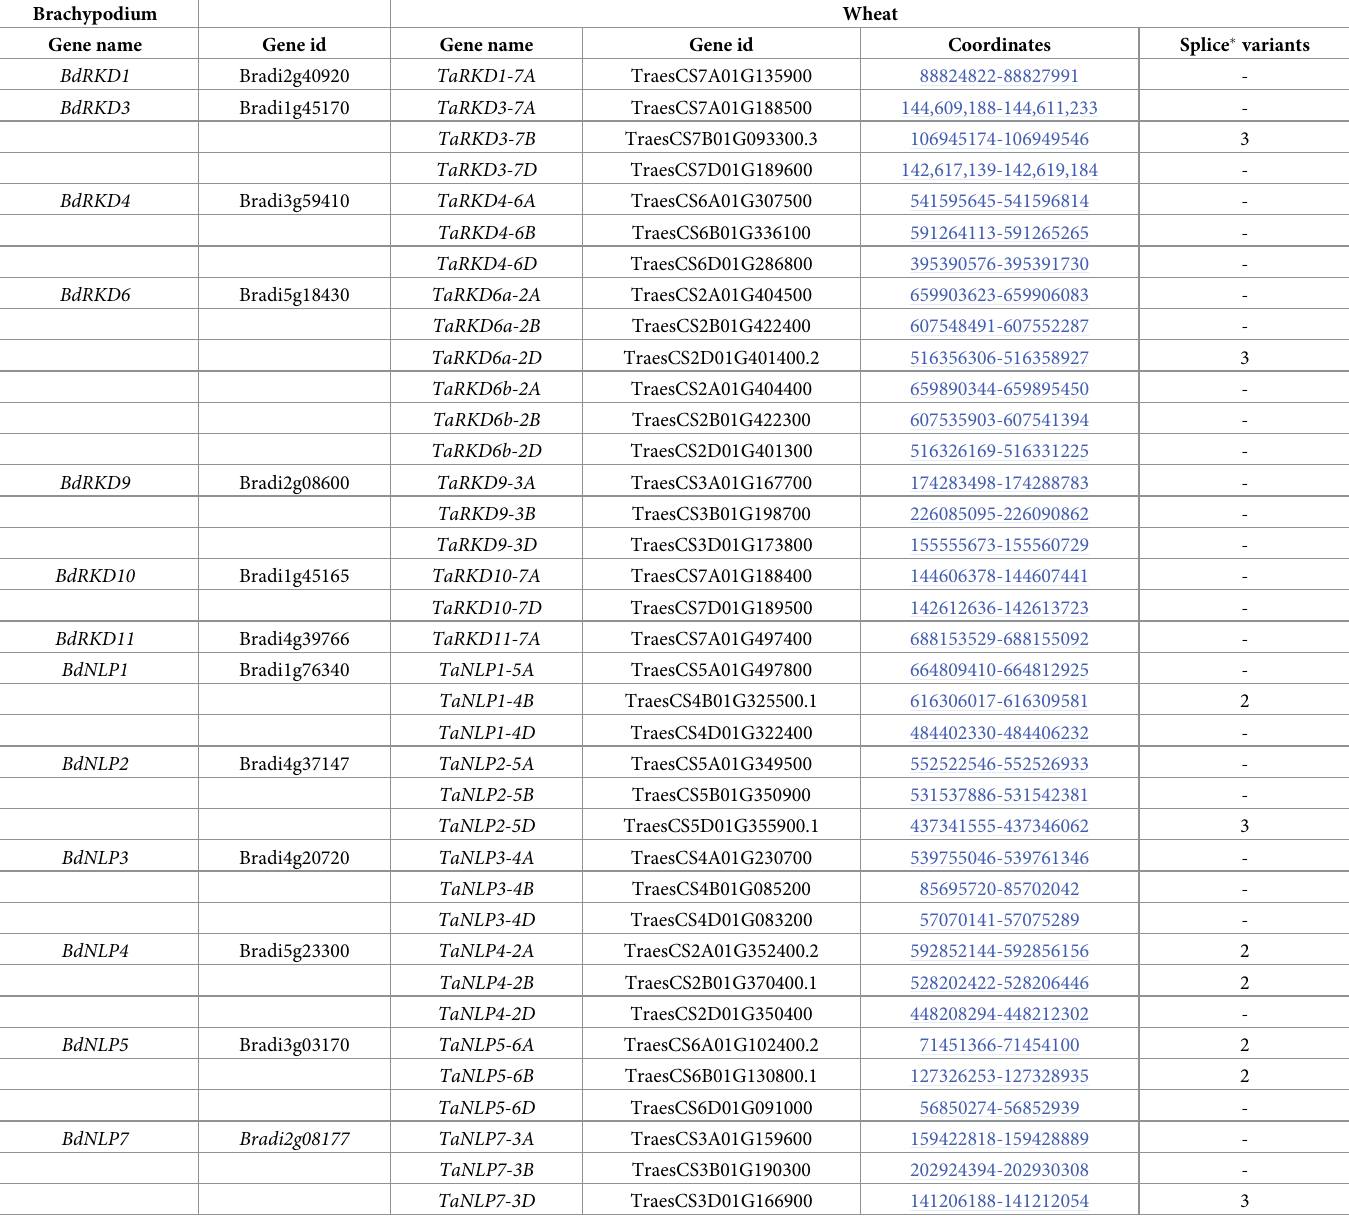
Table 1. A list of RKD and NLP genes of Brachypodium and their putative orthologs in wheat.